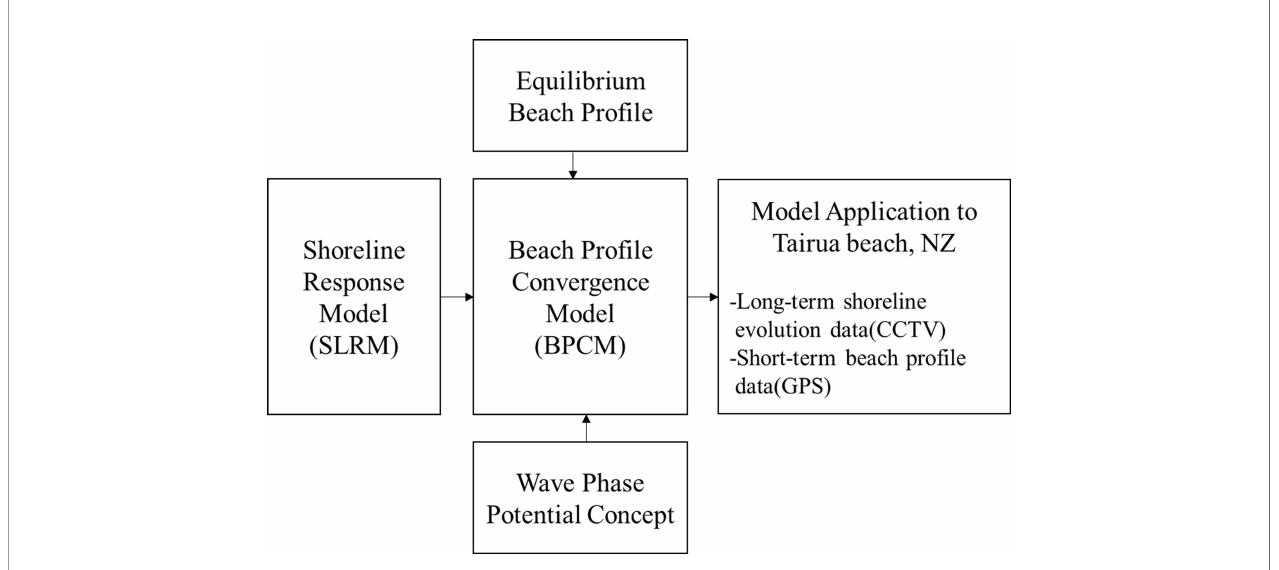
FIGURE 1 | Research